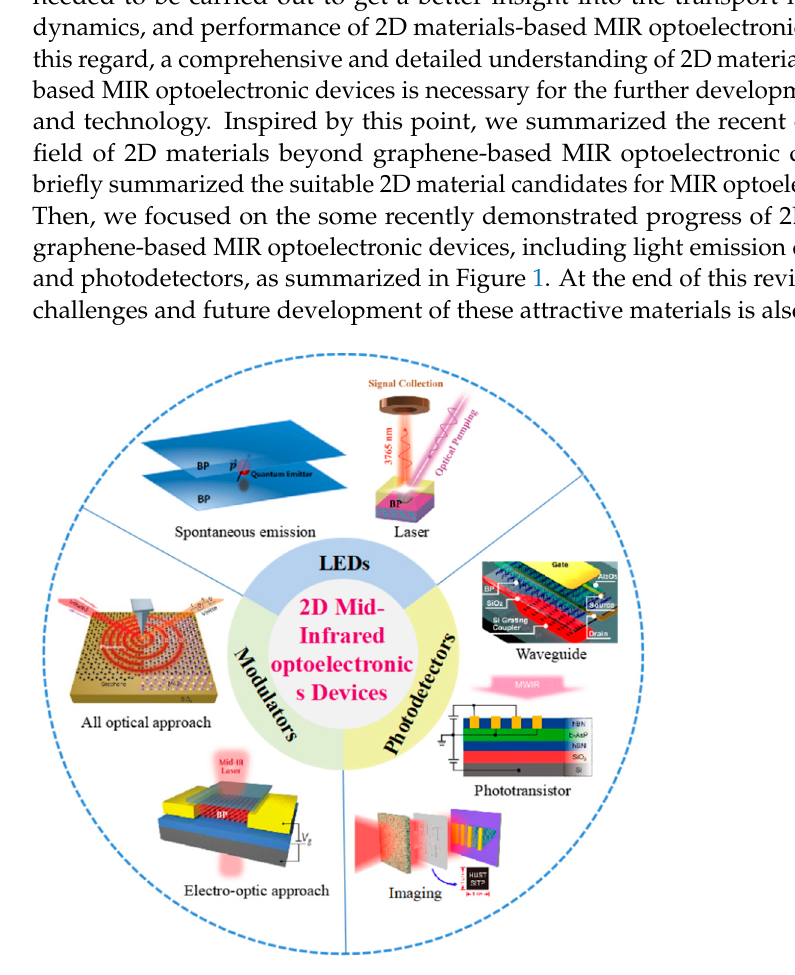
Figure 1. The 2D materials for various MIR optoelectronic applications.